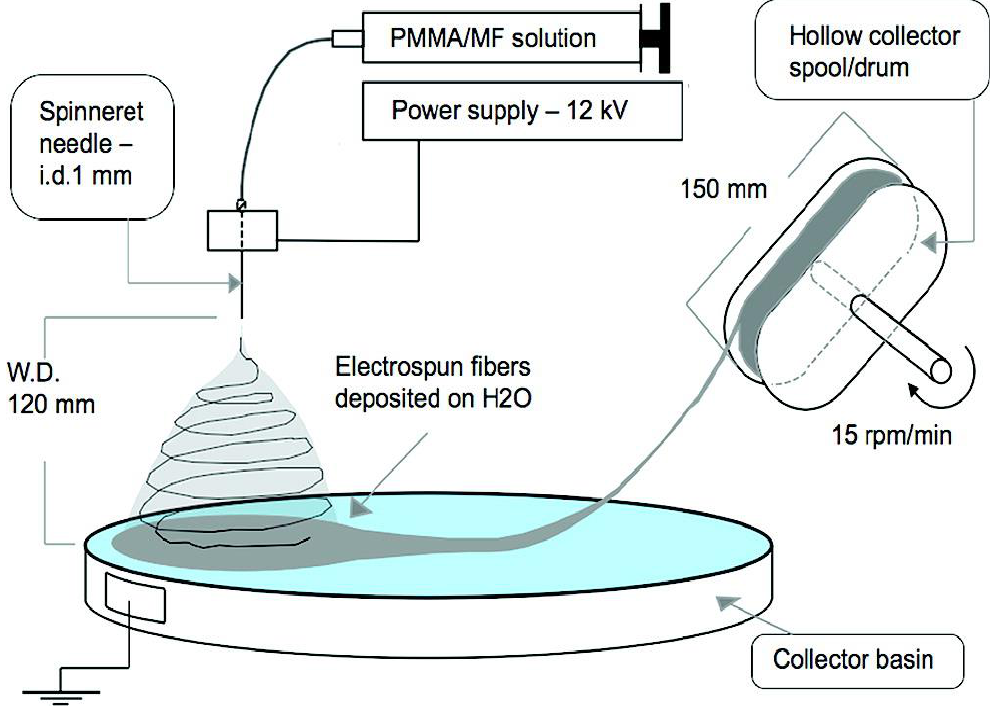
Figure 3. Electrospinning setup with a spinneret–water surface working distance of 120 mm and a spool running at 15 rpm/min. The spool (hollow) was designed to collect fibers with minimal spool–fiber yarn contact [94]. Reprinted with permission from Ref [94]. Copyright American Chemical Society, 2010.